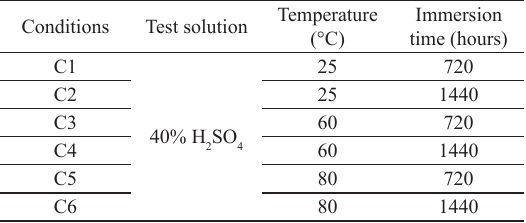
Table 2. Immersion test conditions.